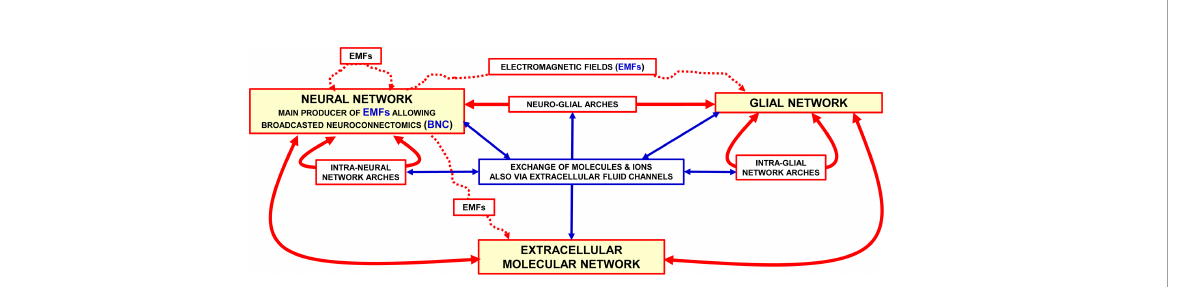
FIGURE 1 Representation of the brain as a “ Brain Hyper-Network ” (see the original article (2). The brain as an ″ hyper-network ″ formed by the integrated assemblage of neural, glia and extracellular molecular networks often organised in compartments of a different size and delimited by plastic boundaries (2). The extracellular molecular network is produced and dynamically modulated by both neurons and glial cells. In turn, the extracellular molecular network plays a role in the formation and dynamic modulation of neuro-glial, intra-neural and intra-glial arches assemblages of components of the three networks form compartments (e.g., functional modules) delimited by plastic boundaries; compartments contain circuits organised according to a ″ Russian Doll pattern ″ (4). This means that macro-scale, mesoscale, micro-scale,